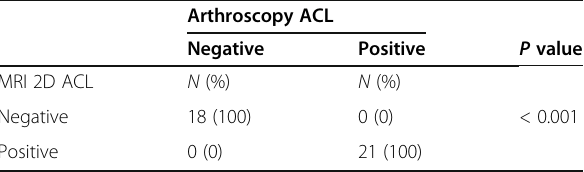
Table 7 Arthroscopic findings correlated with MRI protocol A for ACL lesions